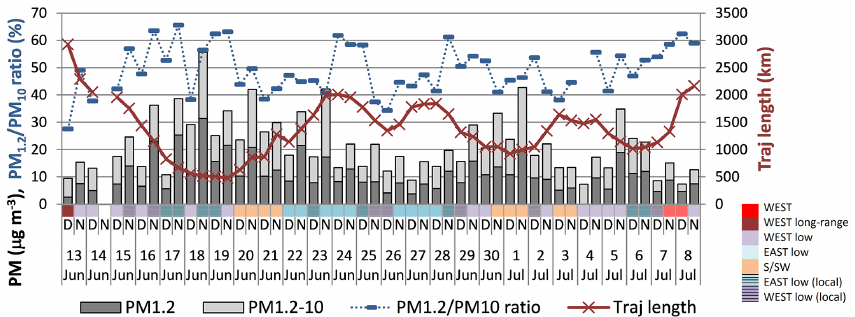
Figure 3. Time series of PM 1 . 2 and PM 10 mass concentrations (in µgm − 3 ) and of the PM 1 . 2 to PM 10 ratio (%) for SPC. Four-day (96h) back-trajectory length (km) is plotted superimposed to the graph, while air-mass classification (in colors) is reported on top of it. The samples are labeled according to collection starting date, with “D” and “N” denoting, respectively, daytime and nighttime samples. Table 1. Fine (PM 1 . 2 ), coarse (PM 1 . 2 − 10 ) and PM 10 mean concentrations (in µgm − 3 , from integrated impactor mass size distributions) for main inorganic ions, water-soluble organic carbon (WSOC) and total carbon (TC) separately for day (D) and night (N) samples during the PEGASOS summer campaign. PM 1 .